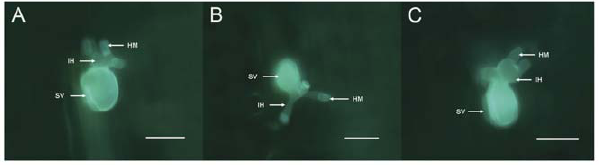
Figure 5. Histological observation of Pst growth using calco- fluor staining. All wheat leaves were inoculated with Pst strain CYR31; fluorescence-microscopic analyses were done 2 days post inoculation. A: BSMV: c :0-as (empty viral vector control); B: BSMV: c : PsCNA1 -as (silencing for PsCNA1 ); C: BSMV: c : PsCNB1 -as (silencing for PsCNB1 ); IH: infection hyphae; HM: haustorial mother cell; SV: substomatal vesicle. Scale bars: 50 m m.